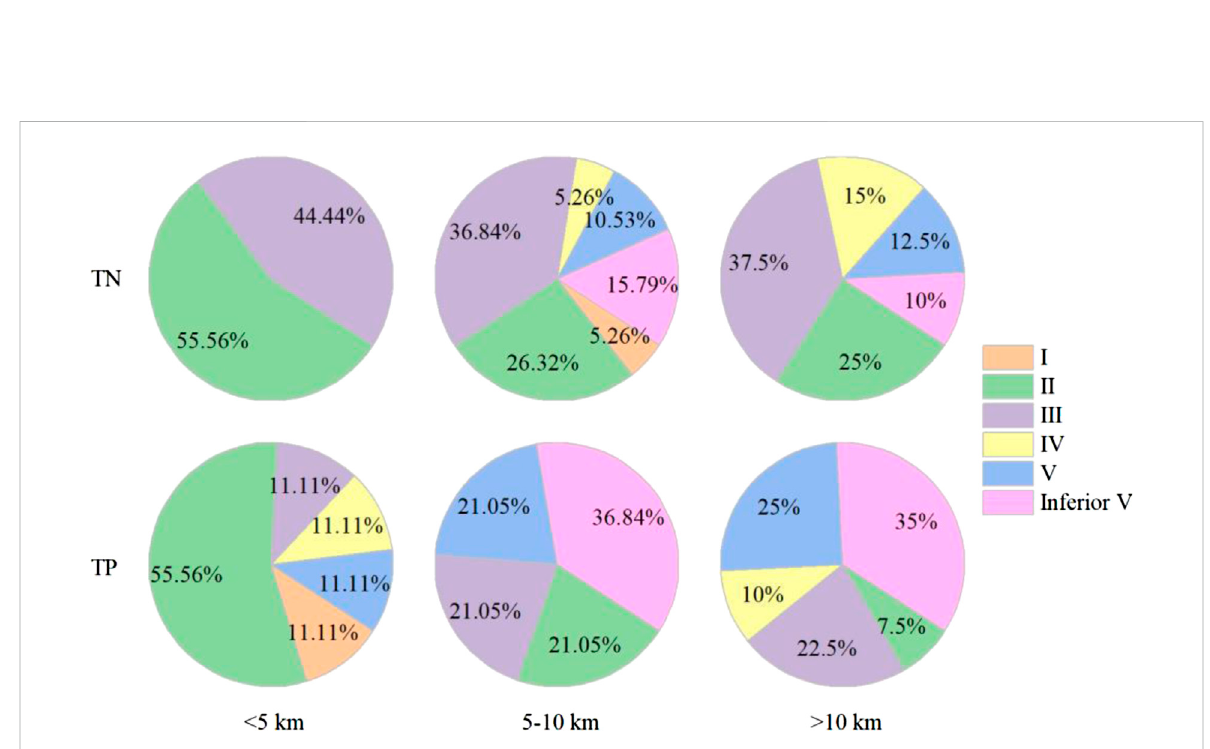
FIGURE 5 Grading comparison of TN and TP concentrations in three distance bands.